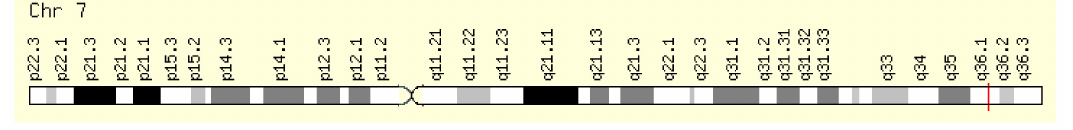
Figure 7. Localization of NOS3 [7].